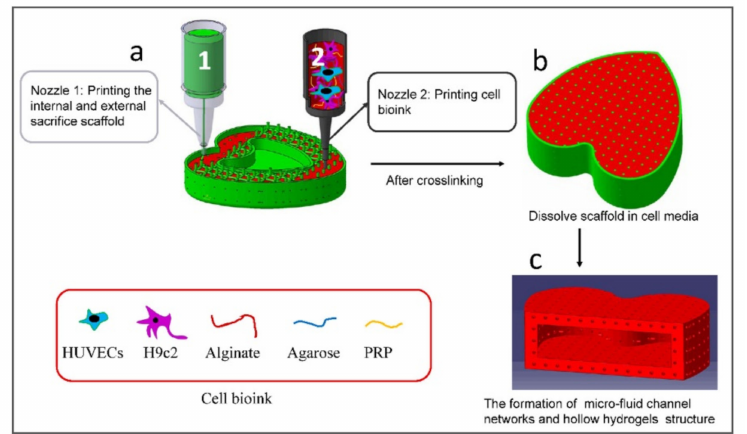
Figure 7. Flow diagram for the biofabrication of the large-size, hollow, and micro-fluid channel networks valentine-shaped heart. Reprinted from [158], with permission from